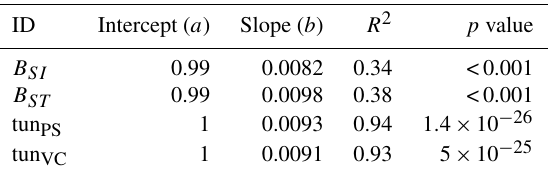
Table A5. Slopes and intercepts of biomass dose–response relation- ships for broadleaved species simulated by O-CN versions based on tuned injury functions to net photosynthesis or V cmax (see Table 1). B SI and B ST represent the simple and standard model by Büker et al. (2015).